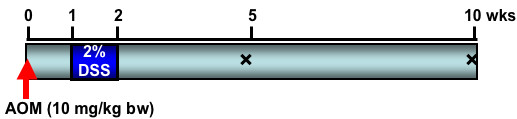
Experimental protocol for the AOM/DSS group.